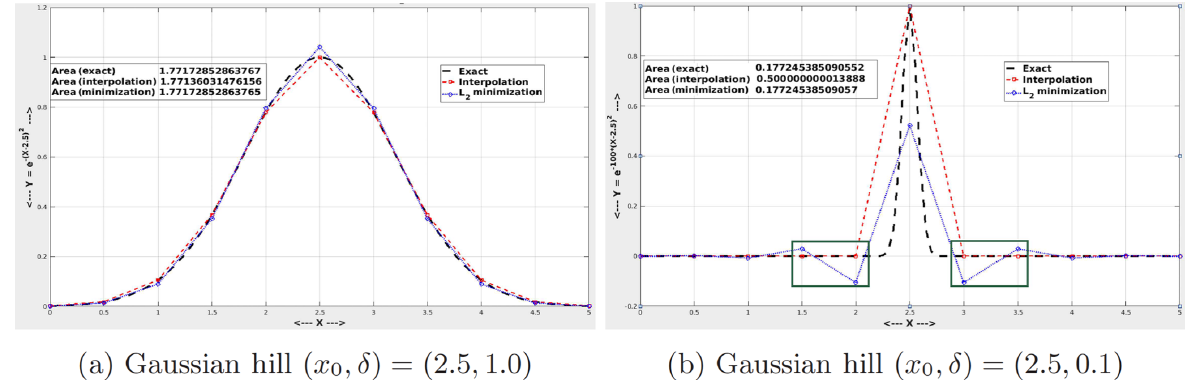
Figure 2. An illustration comparing point interpolation vs. L 2 minimization; impact on conservation and monotonicity properties.